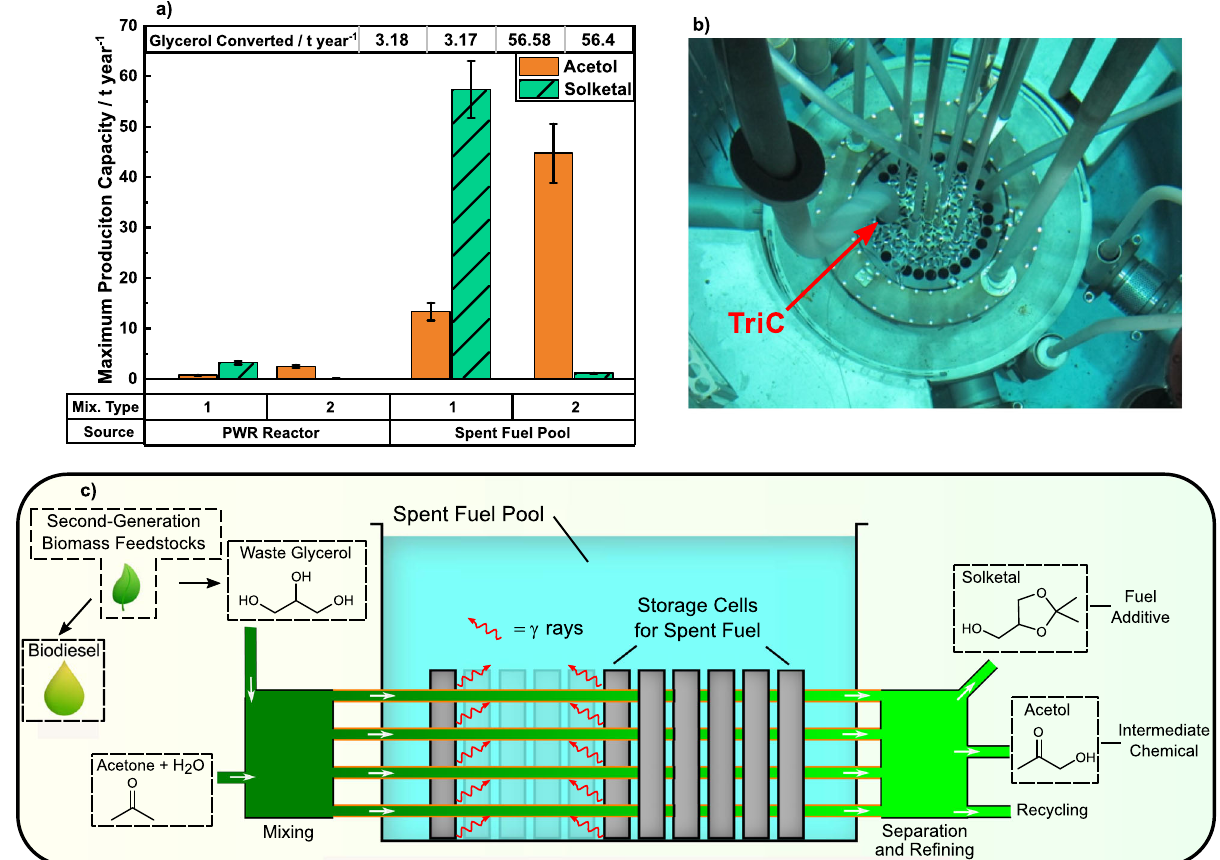
Fig. 5 Annual production capacity and scale-up process models. a Solketal and acetol annual production capacity for (1) ternary acetone, glycerol and water mixture with mol% of 20, 20, and 60, respectively, and (2) a binary glycerol-water mixture with 31 mol% of glycerol. Error bars indicate the propagation of errors from the empirical G -value data. The empirical data (Fig. 2) was obtained using ( b ) the 250 kW TRIGA reactor and the shown Triangular Irradiation Channel (TriC) for irradiations. For scale-up purposes, the two irradiation scenarios were based on geometrical models in MCNP, as per Supplementary Fig. 3. c Nuclear-biore fi nery process schematic depicting a spent fuel storage pool; an equivalent scenario is also plausible for the case of dry storage.